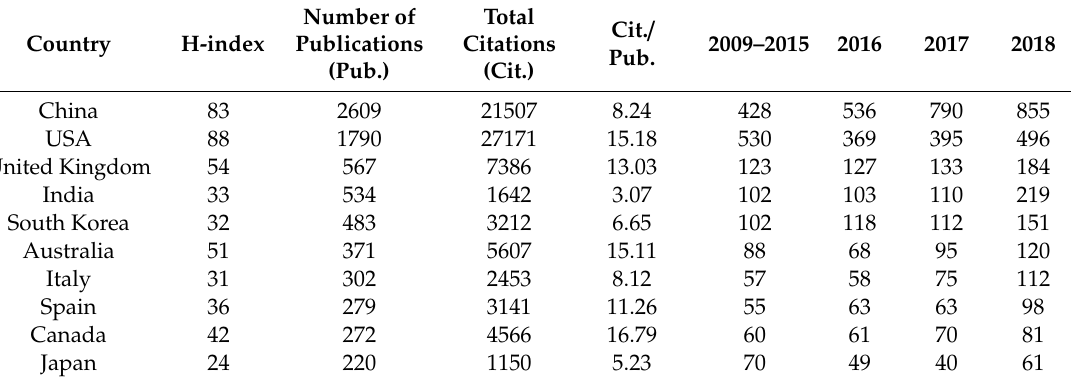
Figure 5. The top 10 productive countries in big data research. Table 2. Top 10 productive countries in big data research.